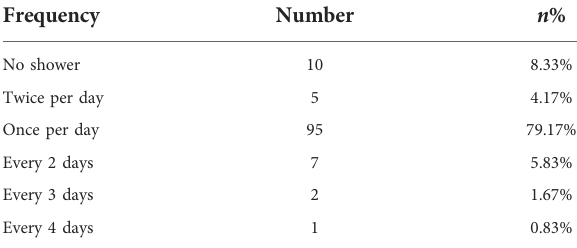
TABLE 5 The results of the shower